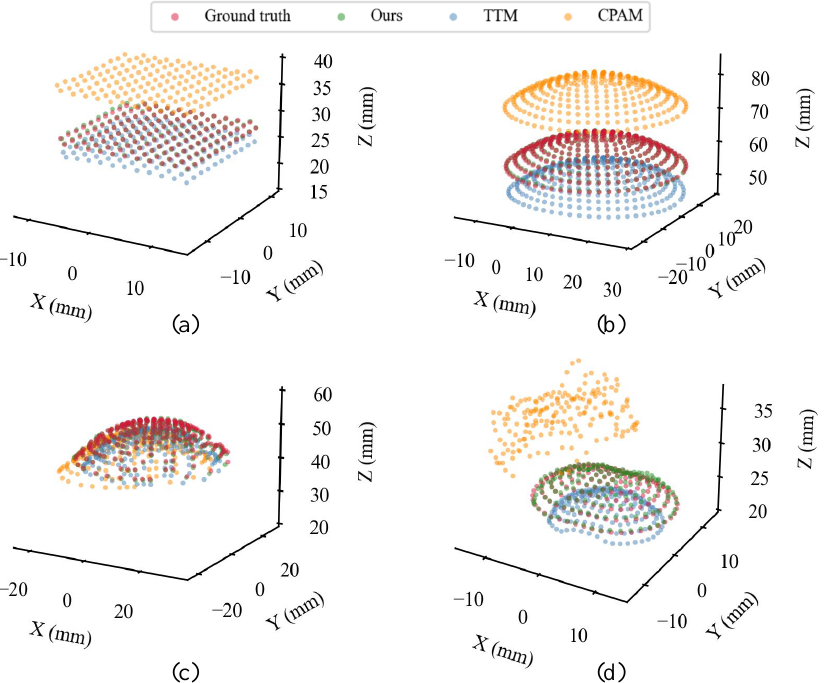
Figure 8. Visualization of tactile 3D point clouds on various sensors using different methods: ( a ) Gel- Stereo Tip, ( b ) GelStereo Palm2.0, ( c ) GelStereo Palm1.0, ( d ) GelStereo